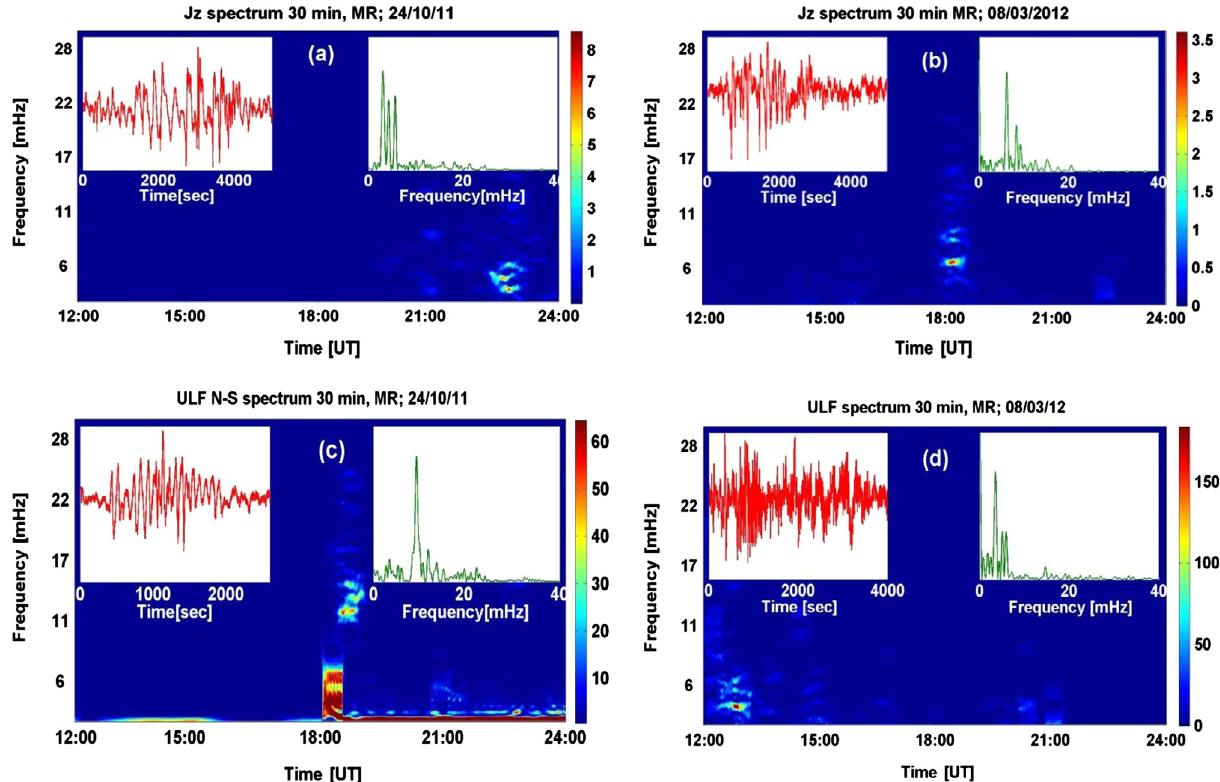
Figure 8. (a) J z dynamic spectrum 24 October 2011. (b) J z dynamic spectrum 08 March 2012. (c) ULF Hns dynamic spectrum 24 October 2011. (d) ULF Hns dynamic spectrum 8 March 2012. Color bars for J z are in pA m (cid:2) 2 /